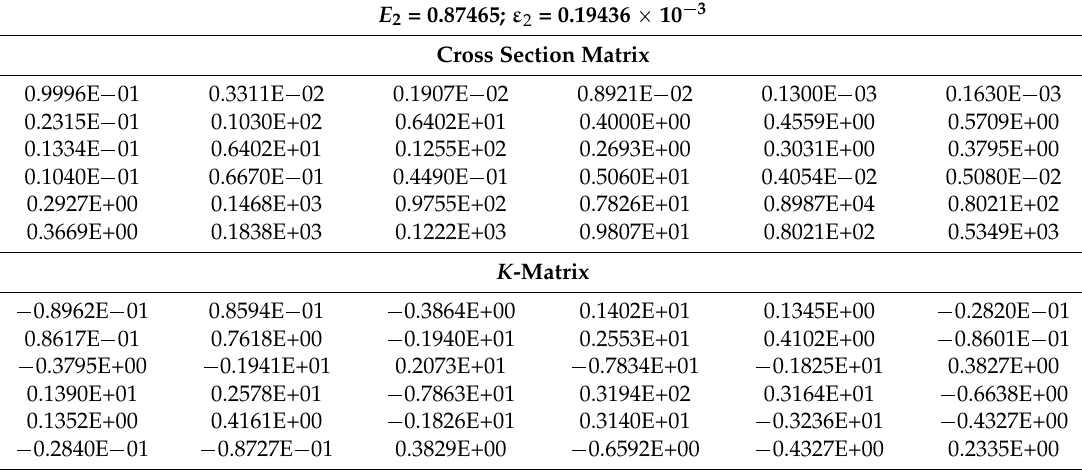
Cross Section Matrix